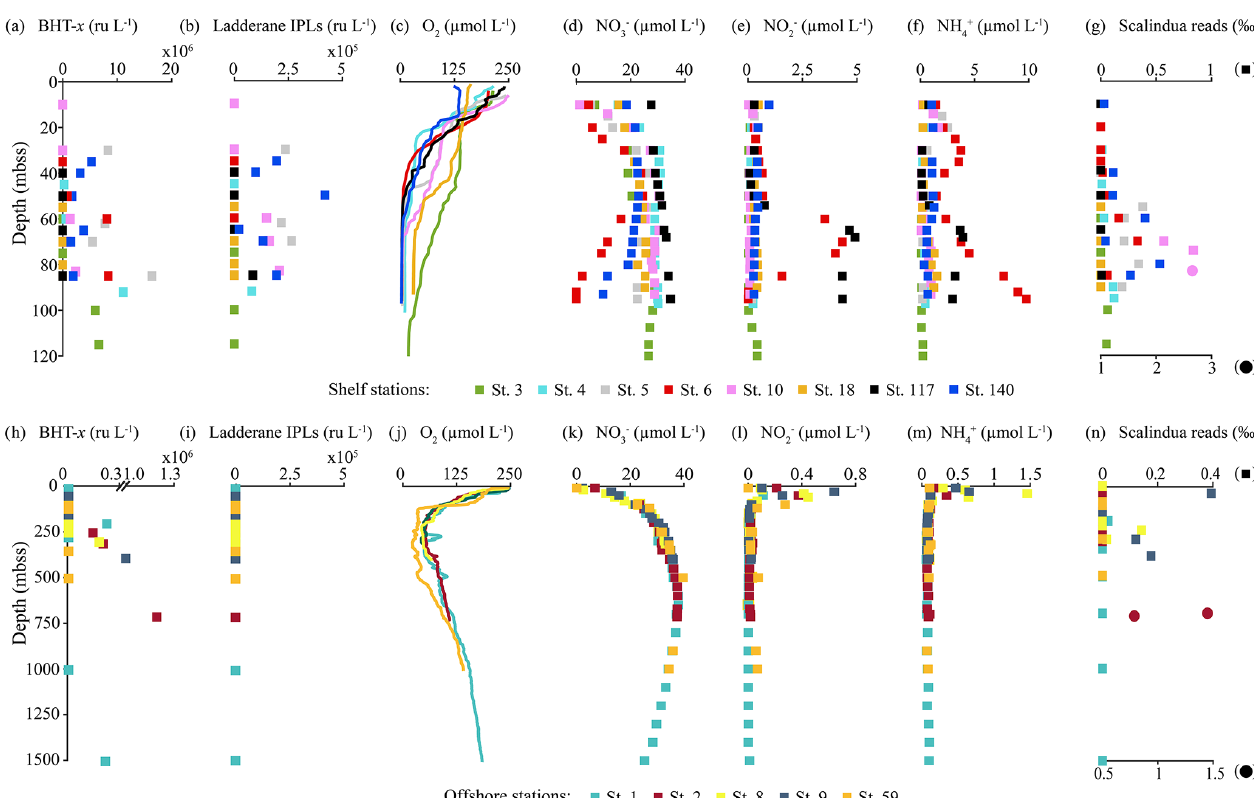
Figure 5. Concentration and relative abundance profiles in the water column of the BUS at shelf (top panels) and offshore (bottom panels) stations. (a, h) BHT- x abundance (ruL − 1 ); (b, i) ladderane IPL abundance (ruL − 1 ); concentrations inµmolL − 1 of (c, j) oxygen [O 2 ], (d, k) nitrate [NO − ], (e, l) nitrite [NO − ] and (f, m) ammonium [NH + ]; and relative abundance of Ca (g, n) . Scalindua spp. reads in per mill of 3 2 4 total bacterial reads (NB circles are plotted on bottom x axis with a different scale).